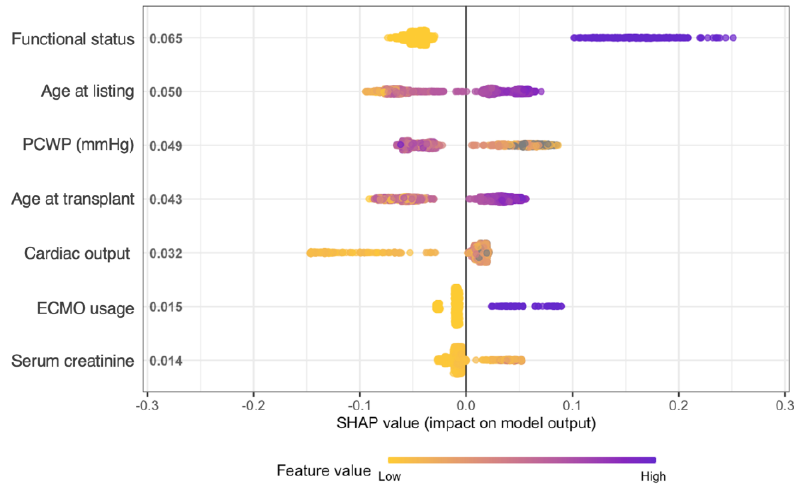
Figure 3. Shapley Additive Explanations (SHAP) summary plot for the top 7 most important features for model prediction, ranked by mean absolute SHAP value. Each dot represents one patient/observation. The x -axis is SHAP value, with a more negative value meaning that the feature for that observation drove the model to predict an outcome of survival at 1 year, while a positive value drove an outcome of death. Yellow and purple colors represent low and high numerical values of the feature in the dataset, respectively. For example, a higher age at listing tended to drive the model to predict death, since there are increasingly purple dots as the SHAP value increases.